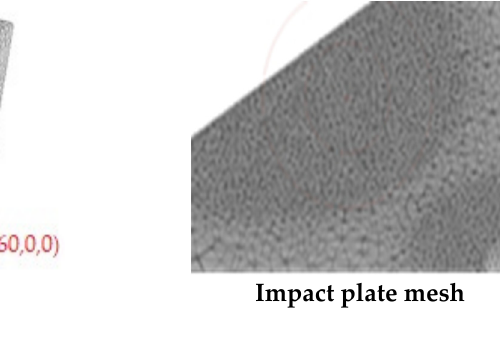
Figure 2. Mesh Model.